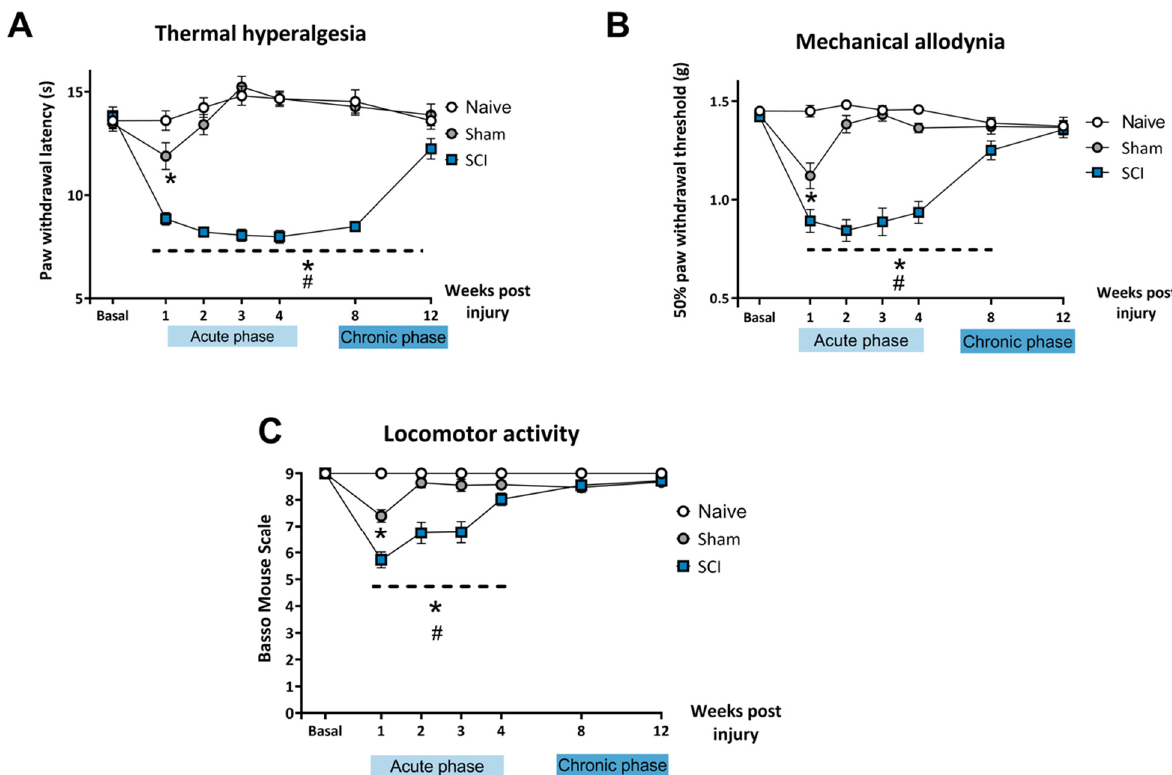
Figure 1. Assessment of mechanical allodynia, thermal hyperalgesia and locomotor activity after a mild spinal cord injury (SCI). Each point and vertical line represent the mean ± SEM. Experimental groups: Naive (n = 18), Sham (n = 28) and SCI (n = 30). ( A ) Thermal hyperalgesia was significantly evidenced in SCI mice until 12 wpi ( B ) Mechanical allodynia was significantly present in SCI mice up to 8 wpi ( C ) Mild BMS alterations referring to altered paw position but not to altered horizontal locomotion were evidenced until 4 wpi. SCI, spinal cord injury; wpi, weeks post injury; BMS, Basso Mouse Scale. * p < 0.05 vs. naïve group, # p < 0.05 vs. sham (Two-way ANOVA followed by Tukey’s post-hoc).